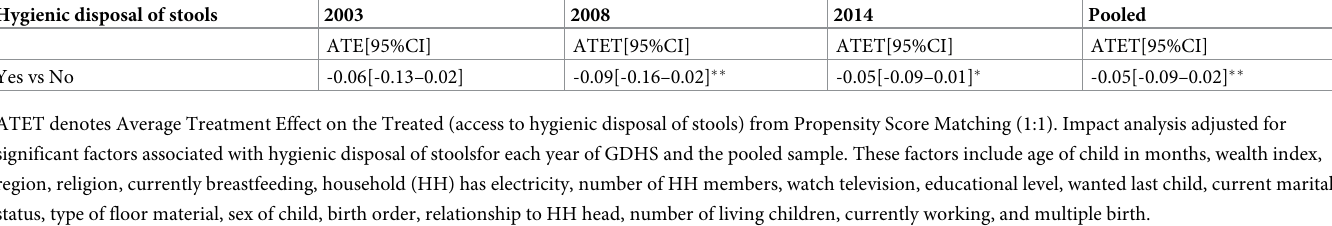
Table 4. Treatment effect of access to hygienic disposal of stools on reducing the risk of diarrhea diseases among women with children under two years in Ghana, GDHS 2003–2014. Hygienic disposal of